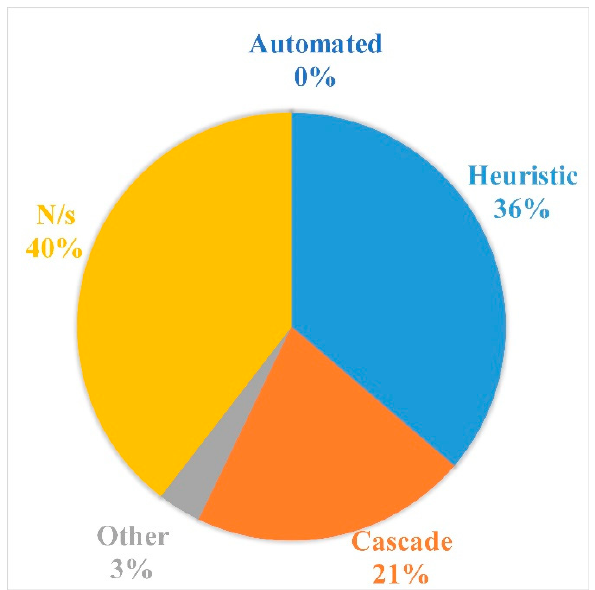
Figure 11. ANN architecture selection